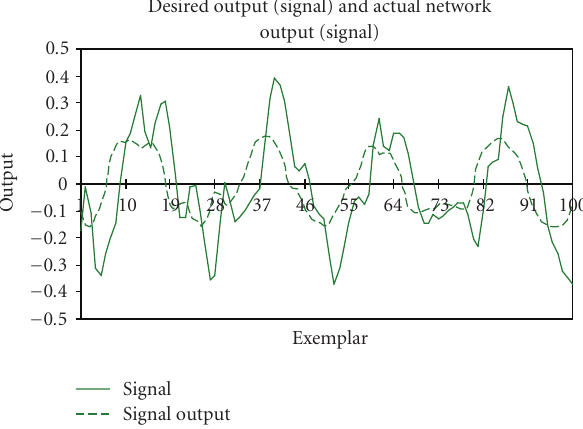
Figure 14: Modeling capability of RBF on test dataset of EMG